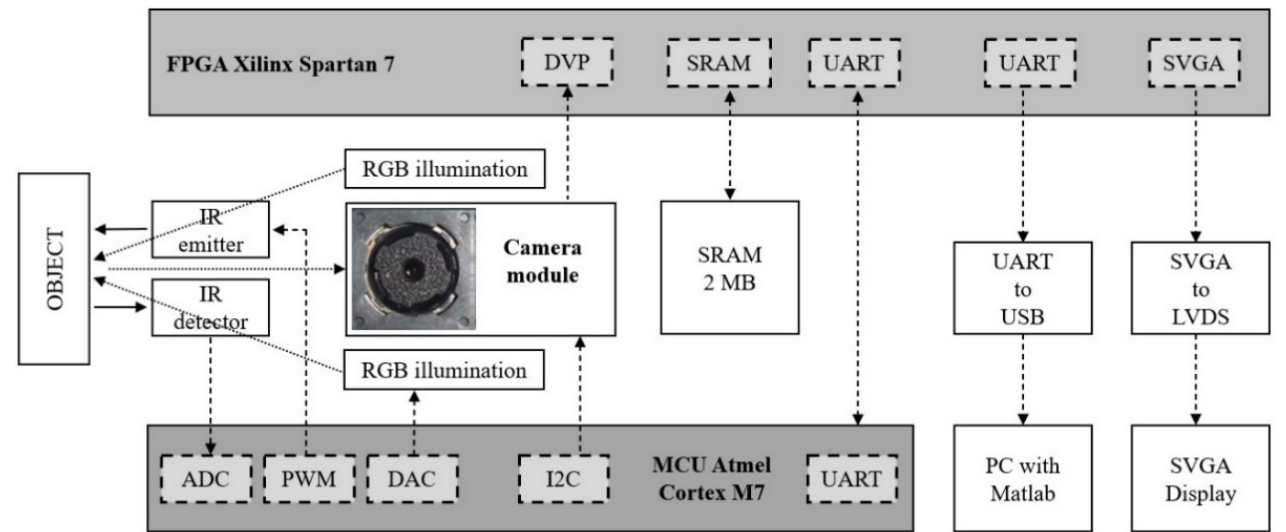
Figure 7. Functional block diagram of the developed eye image acquisition device.